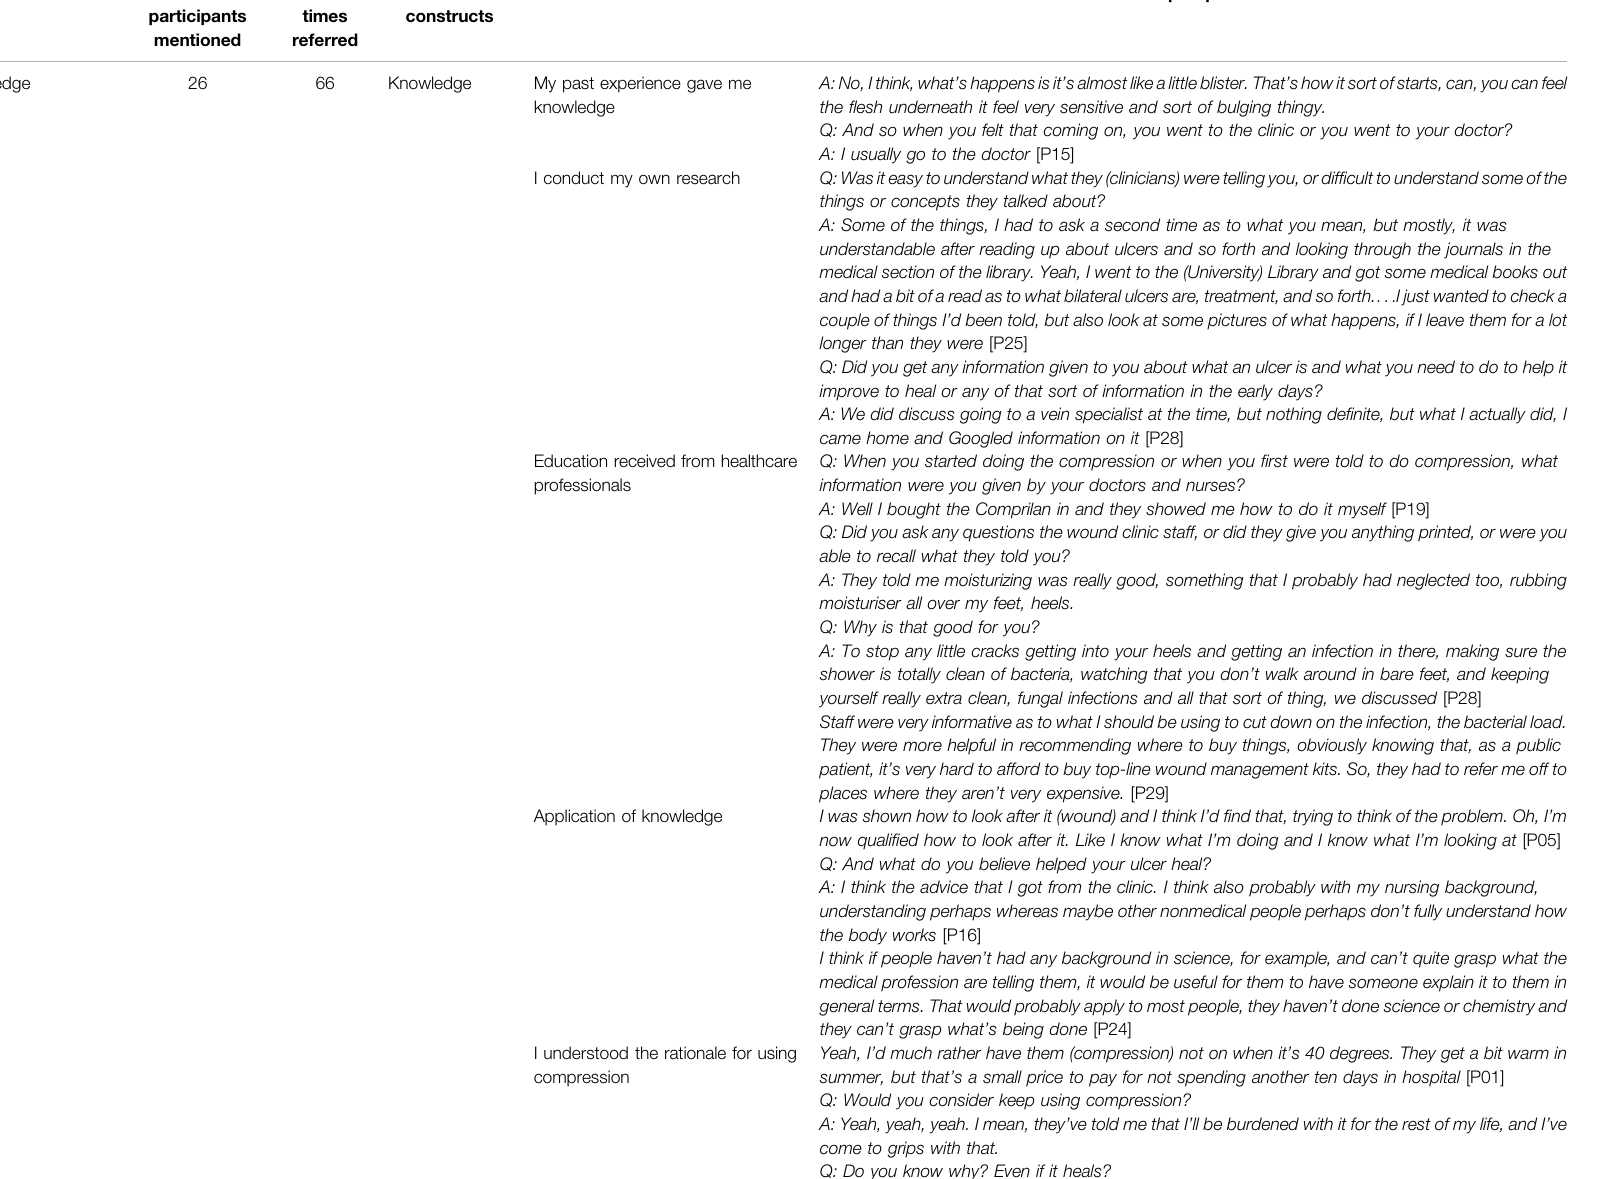
TABLE 4 | Enablers to patients ’ adherence to the evidence-based guideline recommendations for venous leg ulcer management.